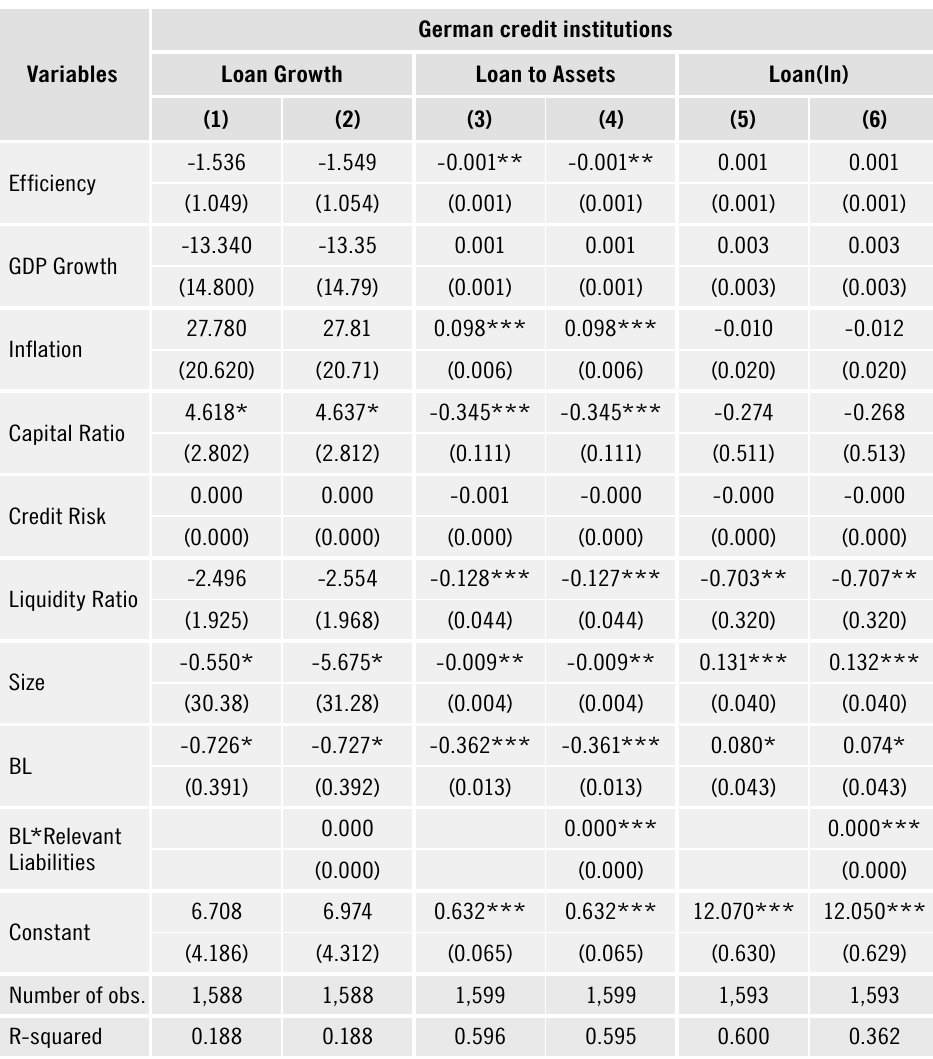
Table 10. Data present estimates based on GLS regressions with a random effect on German credit institutions in 2005–2015. Data have been sourced from unconsolidated financial statements. Institution-specific characteristics appear as one-year lagged variables in all specifications. The bank levy (BL) is represented by a dummy variable indicating 1 for all years the levy applies to, and zero for all remaining years. Robust standard errors that control for clustering at the bank level are reported in